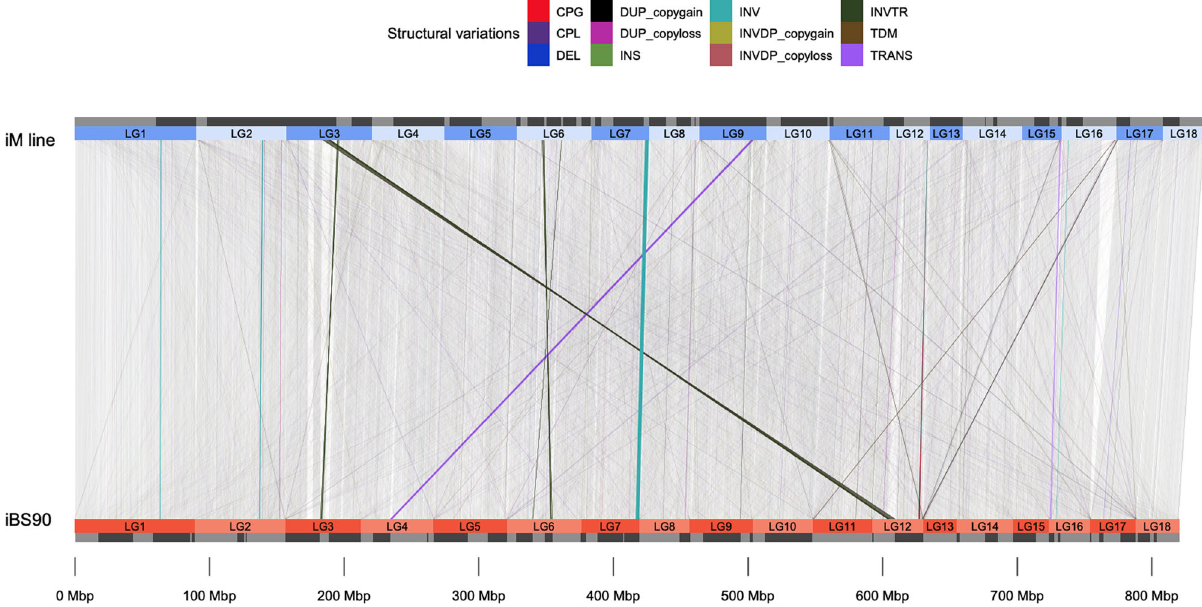
Fig. 1 Synteny plot and structural variations (SVs) between assemblies of iM line and iBS90. The numbers of linkage group were assigned based on the sum of lengths of the scaffold on each linkage group. The linkage groups are marked in colored boxes for iM line (blue on top) and iBS90 (orange at bottom). Separated scaffolds inside each linkage group were marked out as gray and black boxes. Synteny blocks between two genomes are laid out in gray blocks in the background. SV types were highlighted in different colors. Cpg: copy gain in query, Cpl: copy loss in query, DEL: deletion in query, DUP: duplicated region, HDR: highly diverged regions, INS: insertion in query, INV: inverted region, INVDP: inverted duplicated region, INVTR: inverted translocated region, NOTAL: un-aligned region, SNP: single nucleotide polymorphism, SYN: syntenic region, TDM: tandem repeat, TRANS: translocated